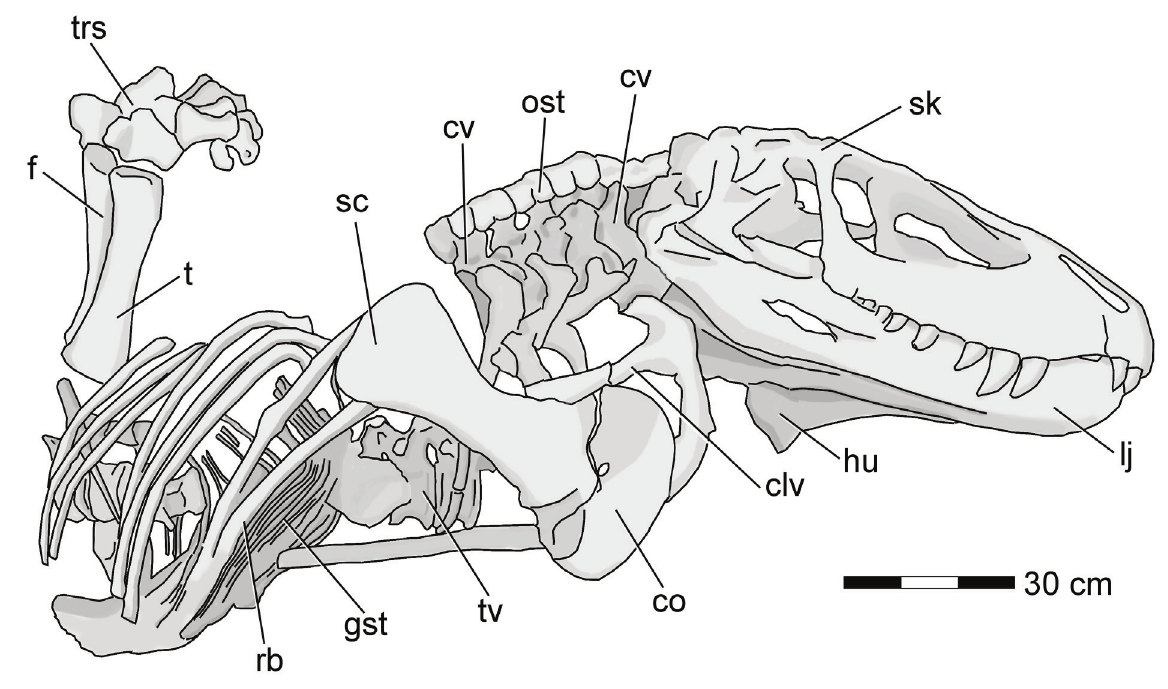
Figure 1 - Schematic drawing of ULBRA-PVT-281, a complete skull and a partial postcranial skeleton. Abbreviations: clv, clavicle; co, coracoid; cv, cervical vertebra; f, fibula; gst, gastralia; hu, humerus; lj, lower jaw; ost, osteoderm; rb, rib; sc, scapula; sk, skull; t, tibia; trs, tarsus; tv, trunk